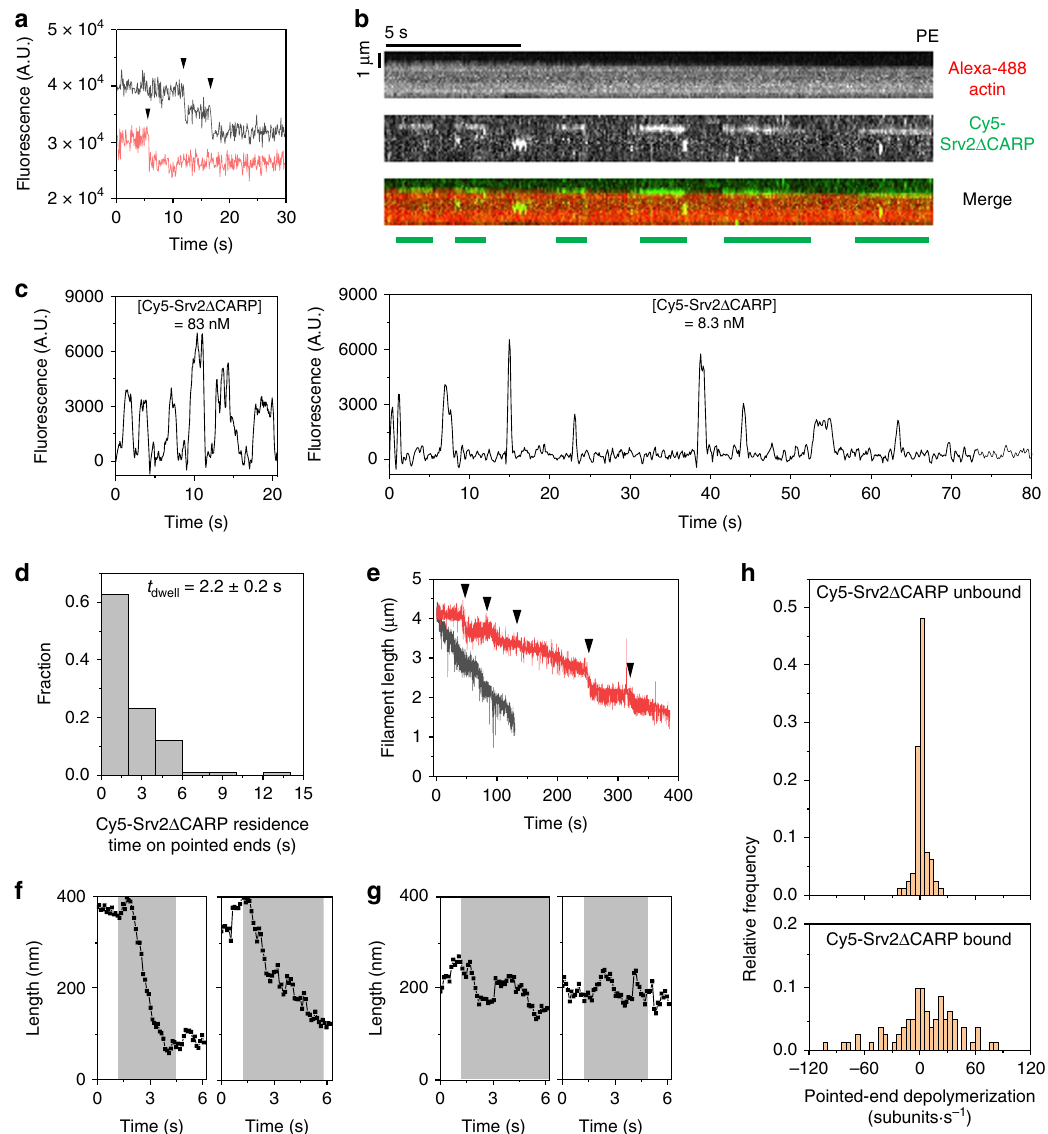
Fig. 4 Direct observation of individual Srv2/CAP molecules interacting with Co fi lin-saturated actin fi laments. a Representative step photobleaching traces for surface-adsorbed Cy5-Srv2 Δ CARP molecules. One of the molecules photobleached in one step (red), and the other in two steps (black). Traces offset for clarity. Arrowheads denote photobleaching events. b Depolymerization of an Alexa-488 actin fi lament in the presence of 1 μ M Cof1 and 83 nM Cy5- Srv2 Δ CARP, recorded at high time resolution (0.065 s per frame) (a segment of the recording in Supplementary Movie 2). Kymographs show Alexa-488 actin (top), Cy5-Srv2 Δ CARP (middle), and merge (bottom). Green bars denote episodes in which a Cy5-Srv2 Δ CARP molecule was present at the pointed end of the fi lament. c Time records of Cy5-Srv2 Δ CARP fl uorescence intensity at the depolymerizing pointed ends of two actin fi laments in 1 μ M Cof1 and 83 nM (left; same record as in b ) and 8.3 nM (right) Cy5-Srv2 Δ CARP. Intensity is integrated over a 5 × 5 pixel square and smoothed with a 0.71 s sliding window. d Distribution of residence times of Cy5-Srv2 Δ CARP molecules at pointed ends ( n = 126; data pooled from 8.3 nM (two fi laments) and 83 nM ( fi ve fi laments) Cy5-Srv2 Δ CARP conditions). e Length records of two fi laments depolymerizing in the presence of 1 μ M Cof1 and either 83 nM (black) or 8.3 nM (red) Cy5-Srv2 Δ CARP. Arrowheads indicate episodes of rapid depolymerization in the red record. f , g Excerpts of length records like that in ( e ), red, showing measured fi lament length during individual Srv2 binding events (shaded intervals). Examples are shown of binding events that are ( f ) or are not ( g ) accompanied by rapid depolymerization. h Distributions of depolymerization rates of actin fi laments during periods when Cy5-Srv2 Δ CARP is absent (top) or present (bottom) at the pointed end of an actin fi lament. Source data are provided as a Source Data fi